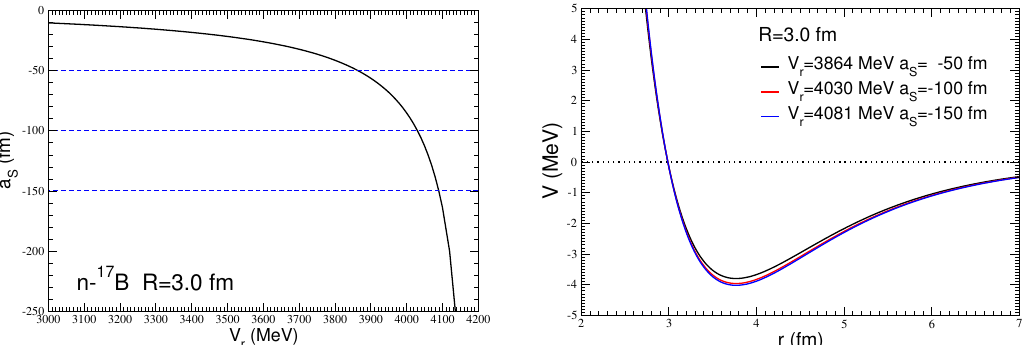
Figure 5: Dependence of the n - 17 B scattering length a panel). Dashed lines correspond to some selected values of a and corresponding strength values V (right panel)